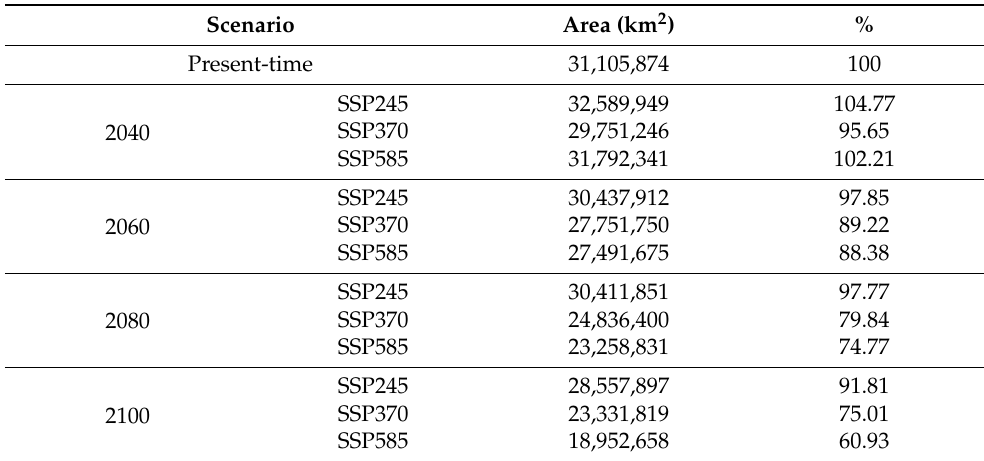
Table 1. Evolution of the estimated potential distribution area of Sympetrum flaveolum in absolute and relative values (Present—2100). 80–100%.